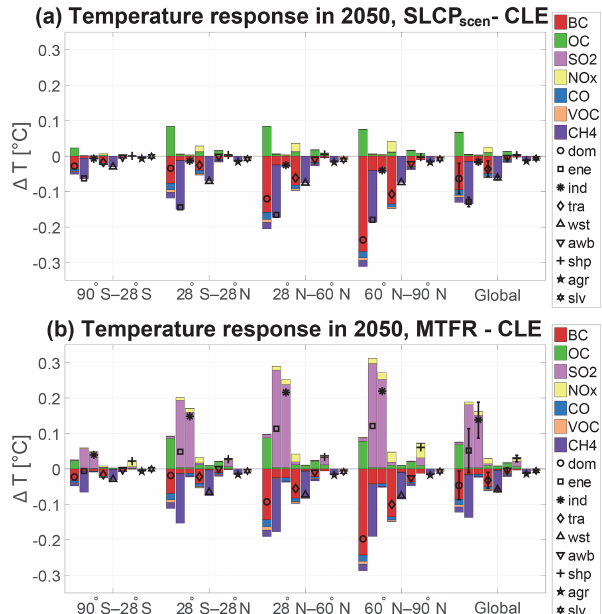
Figure 3. The temperature response in the latitude bands and globally in 2050 for emission regions and emission sectors for (a) SLCP scen and (b) MTFR scenarios relative to the baseline CLE. The emission regions are Europe (EUR), East Asia (EAS), global shipping (SHP), and the rest of the world (ROW). The net response in the latitude bands due to emissions from each emission region is given by the symbols. The emission sectors are agriculture (agr), agriculture waste burning (awb), domestic (dom), energy (ene), in- dustry (ind), solvent (slv), transportation (tra), waste (wst), and shipping (shp).